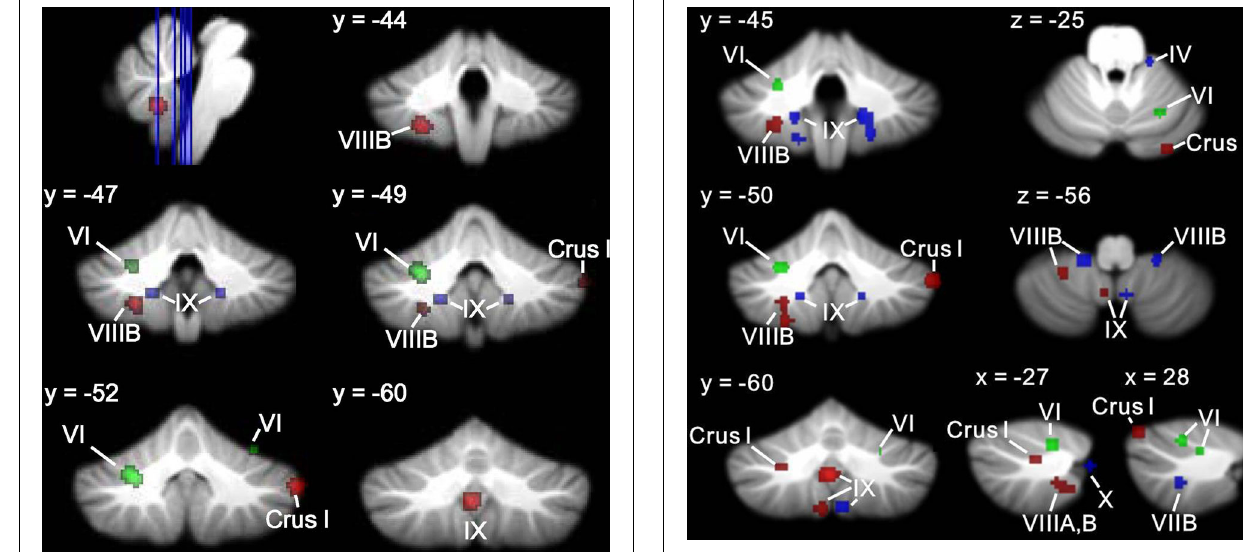
FIGURE 6 | Different cerebellar regions affected in ASD vs. ADHD vs. dyslexia. Coronal slices through the cerebellum show clusters of GM decreases in ASD (red), ADHD (blue), and dyslexia (green).